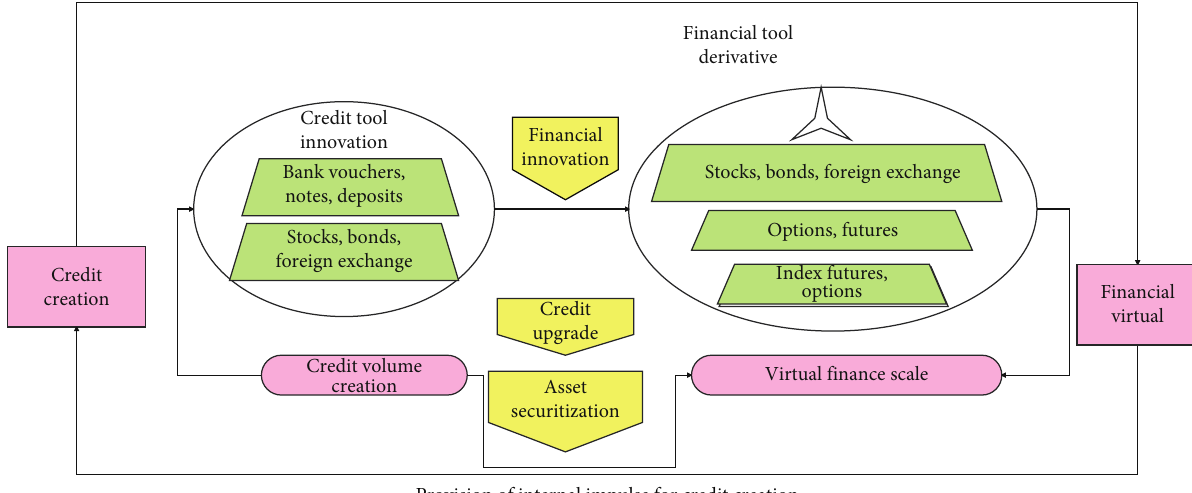
Figure 5: Credit creation and virtual economy operation model.